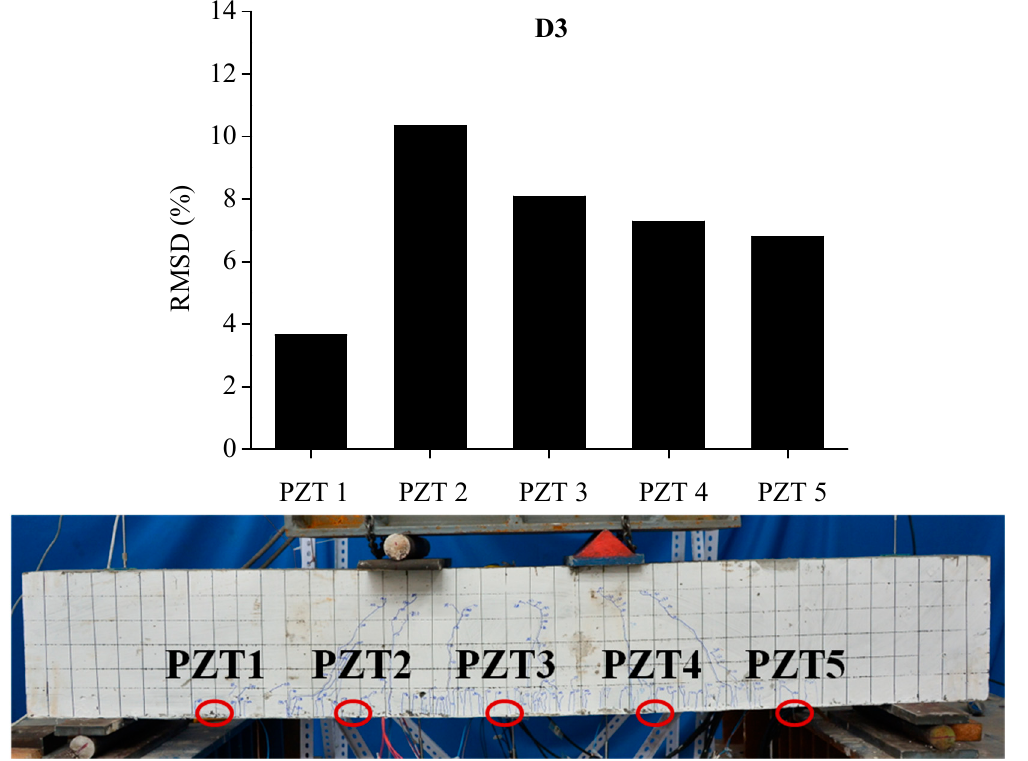
Figure 15. RMSD of each PZT sensor at D3 and the related cracking pattern of BE1.